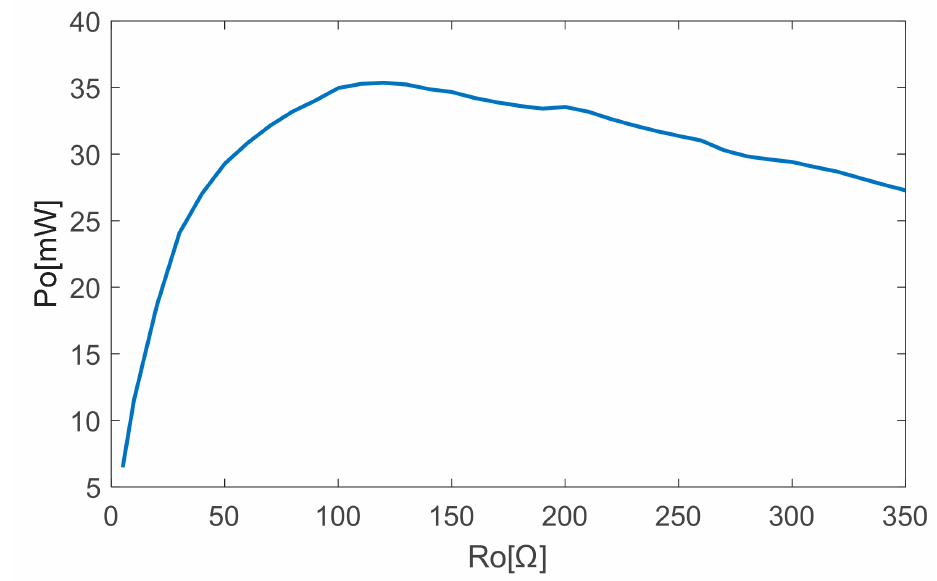
Figure 9. The power matching curve measured for the tested TE panel